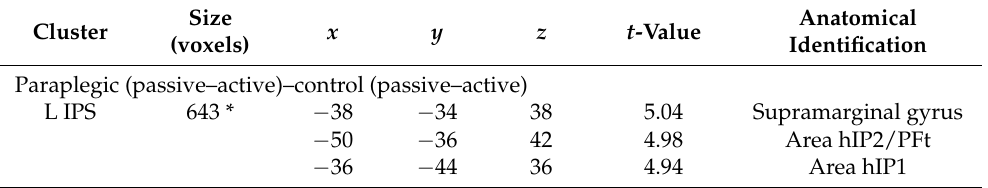
Anatomical Identification